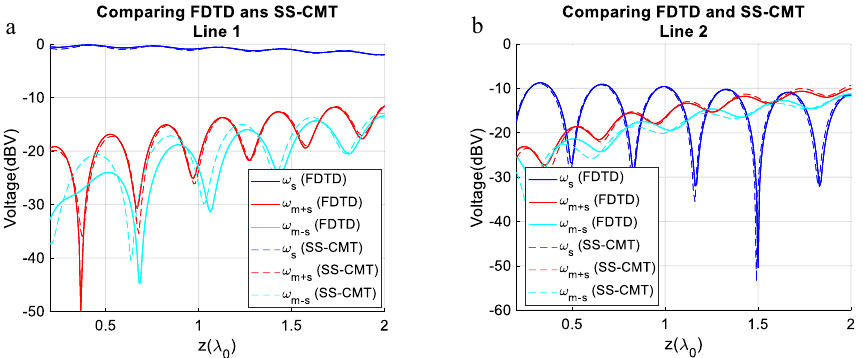
Figure 3. The evolution of the main three harmonics along the lines, ( a ) line 1 and ( b ) line 2. The modulation give rise to